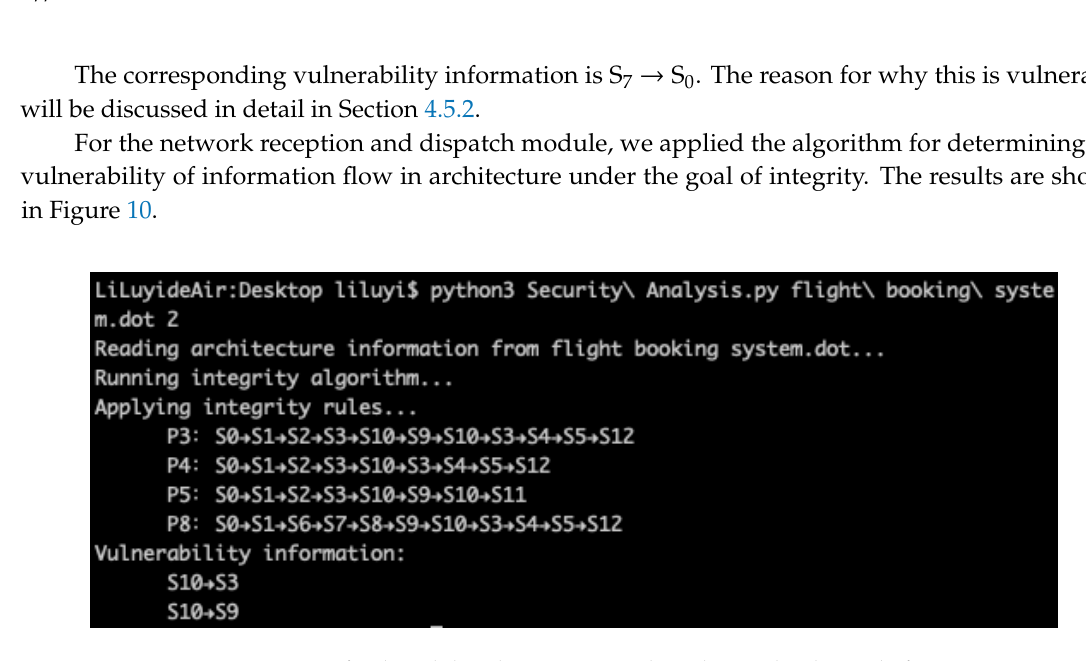
Figure 9. Output of vulnerability determination algorithm under the goal of confidentiality.